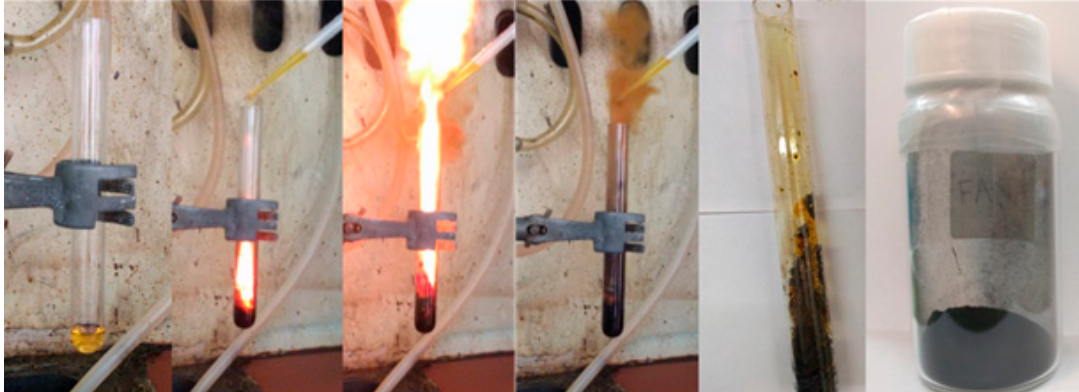
Figure 1. Fuming nitric acid and furfuryl alcohol reacted energetically upon contact to form a crude carbon residue inside the “rocket” test tube. Collection and washing of the residue afforded a fine carbon powder. Notice the release of brown nitrogen oxide gases as a result of nitric acid decomposition by furfuryl alcohol.